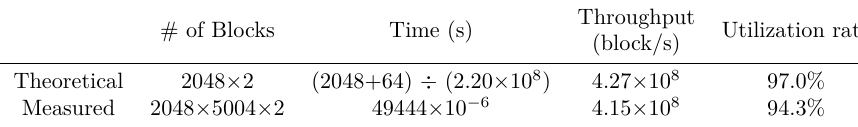
Table 6: Utilization rate of the block transform unit (two